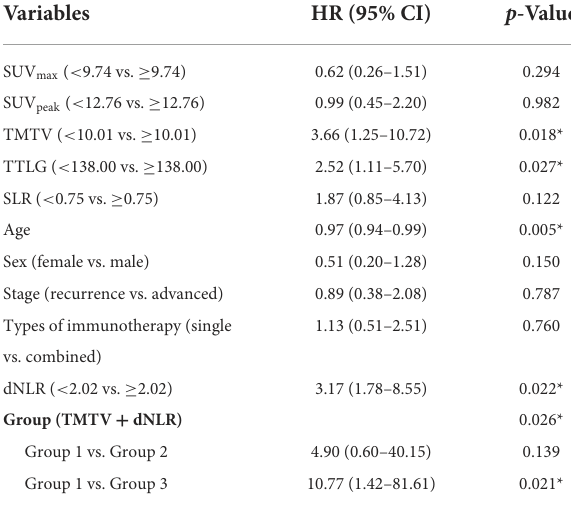
TABLE 1 Patient characteristics ( n = 39). TABLE 2 Univariable analysis for PFS by Cox proportional hazard